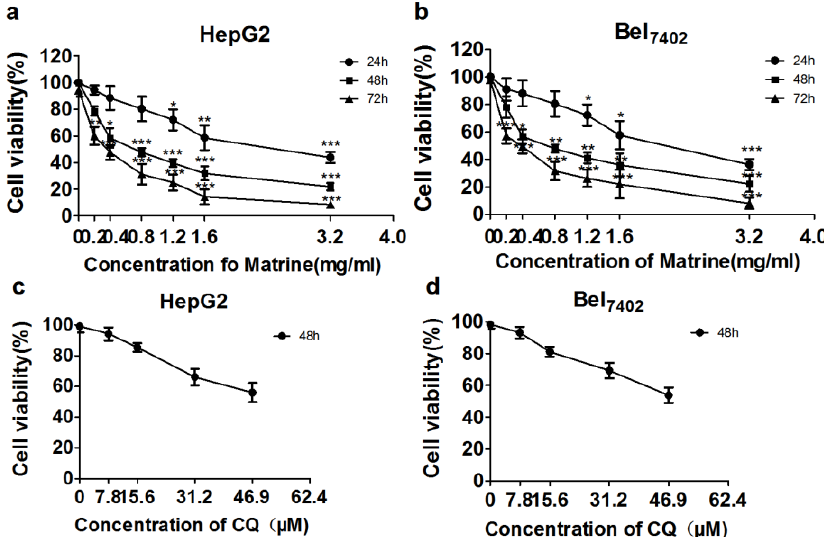
Figure 1. MTT assay showing the cytotoxicity of matrine or CQ on HCC cells. ( a ) HepG2 and ( b ) Bel cells were treated with matrine at concentrations of 0.2, 0.4, 0.8, 1.2, 1.6, 7402 and 3.2 mg/mL for 24, 48, and 72 h. Matrine inhibited the growth of HepG2 and Bel cells in a dose- and time-dependent manner. The optimal concentration was determined by the half maximal inhibitory concentration calculated using GraphPad software; ( c ) HepG2 and ( d ) Bel cells were also treated with CQ at concentrations of 7.8, 15.6, 31.2, 7402 and 46.9 µM for 48 h. Data are means ± SD of three independent experiments. * p < 0.05, ** p < 0.01, *** p < 0.001 vs . control